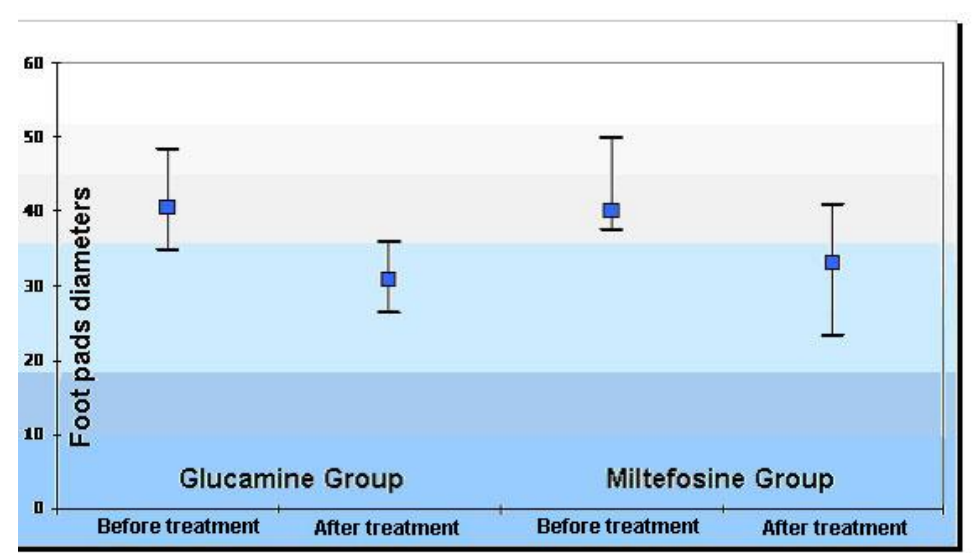
Figure 1. Diameters (mm) of mice foot pads inoculated with N-methyl glucamine only (Glucamine Group) and with N-methyl glucamine plus topical miltefosine (Miltefosine Group) before and after treatment (p>0.05).